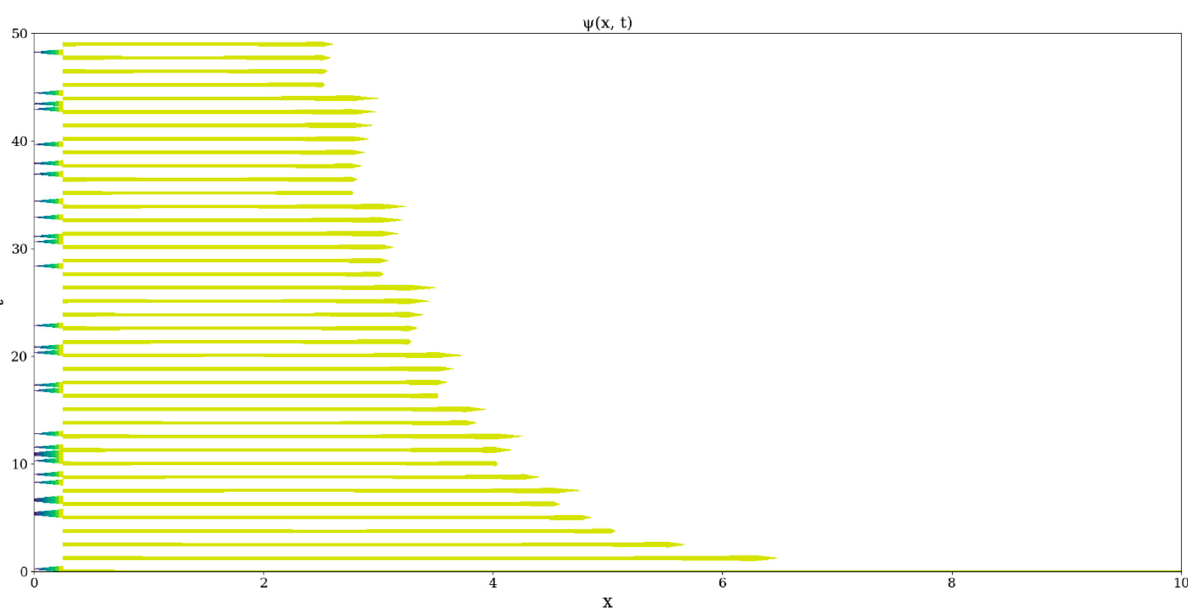
Figure 4. Example plot of ψ(x, t) ; ω constant odd integer.